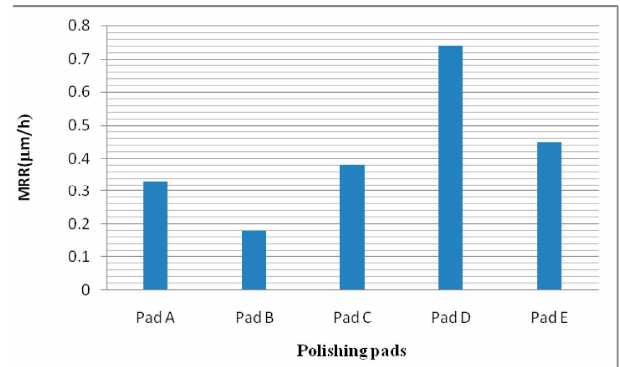
Figure 3. Comparison of material removal rates using different polishing pads.